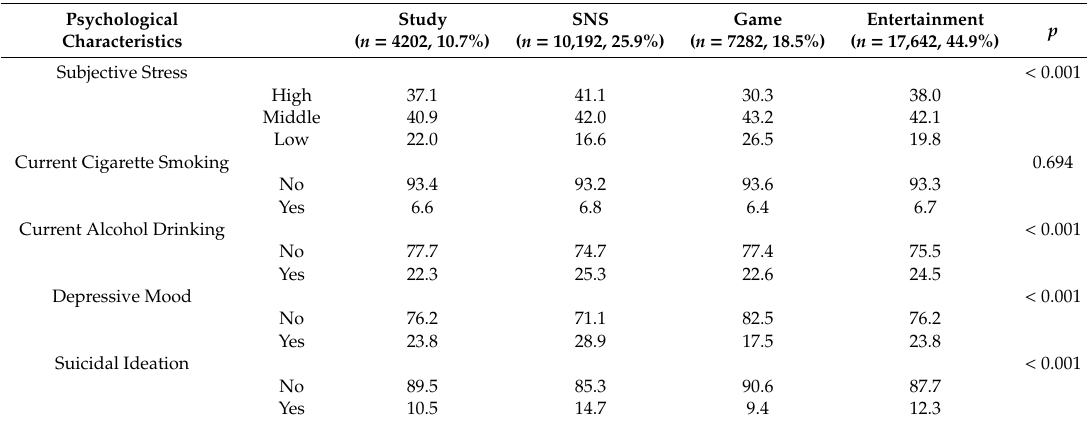
Table 2. Psychological characteristics of participants, according to content type of smartphone use.